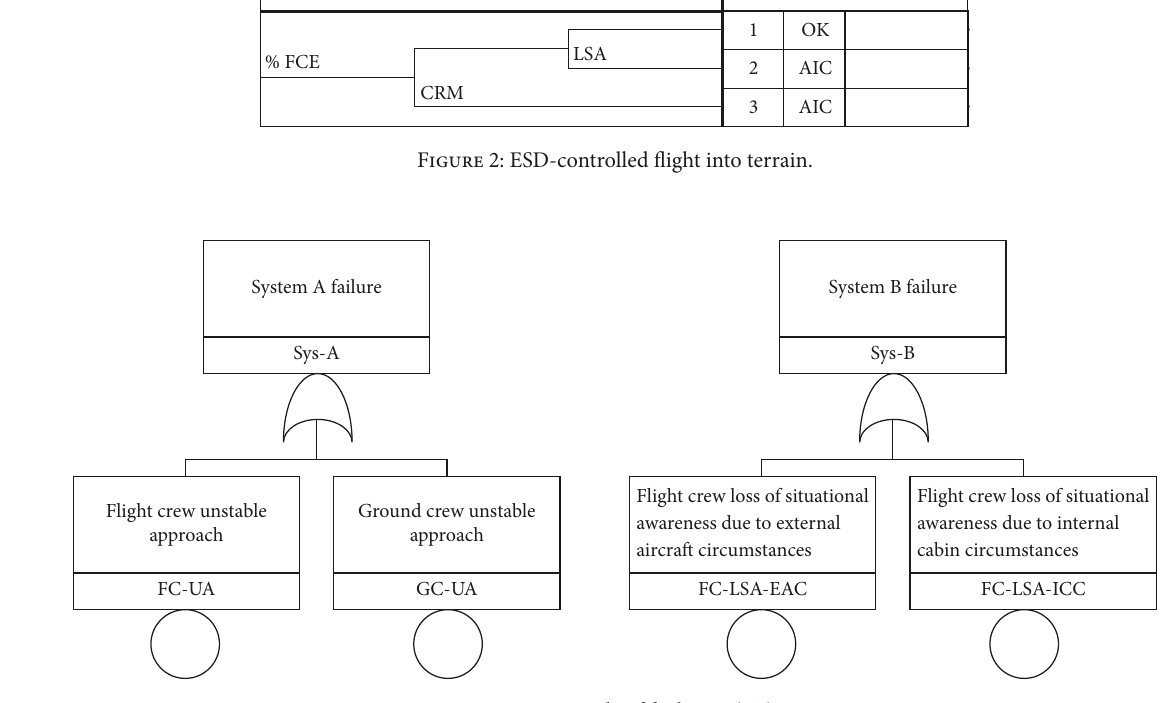
Figure 3: Example of fault tree